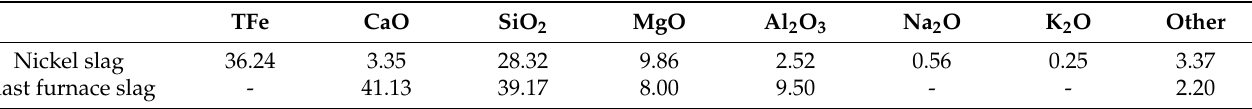
Table 1. Raw material compositions of nickel slag and blast furnace slag (wt%).